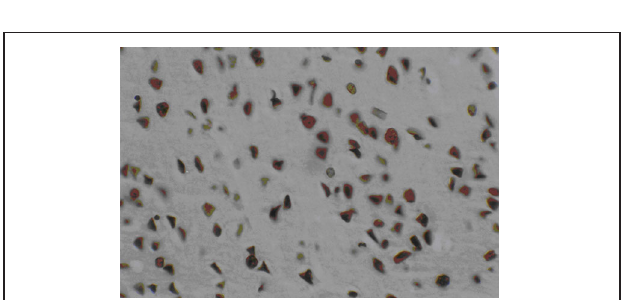
FIGURE 3 | TUNEL findings of the ischemia group at 28 days after sham transplantation.